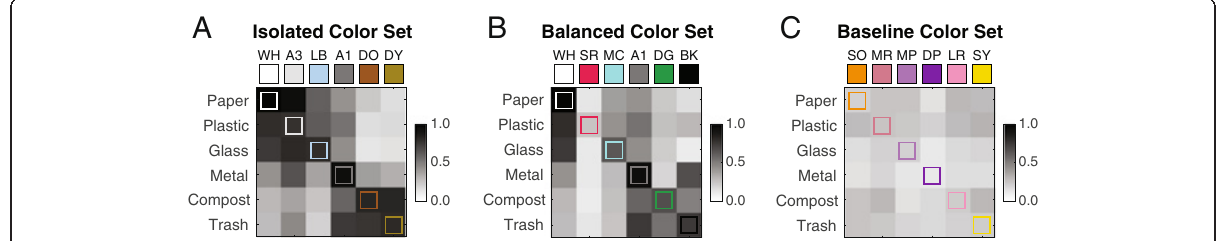
Fig. 8 Color-object association matrices for all color-object pairs within each of the three color sets: ( a ) isolated, ( b ) balanced, and ( c ) baseline. Data are from the pilot experiment reported in Additional file 1 and are also shown in Fig. 4. The diagonal of each matrix indicates the encoded color- object assignment (correct answer) for each